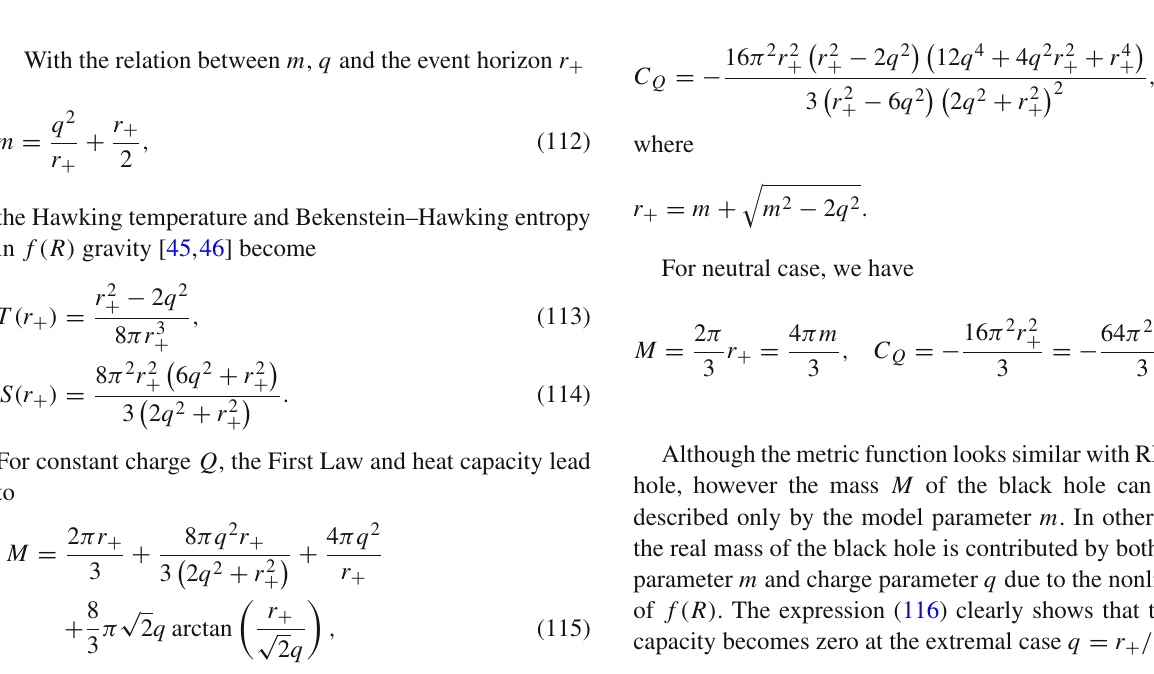
Fig. 4 The black curves represent RN black hole in Einstein gravity while the cyan curves represent our black hole in f ( R ) gravity in ( 3 + 1 ) - dimensions. In addition, the full lines, the dashed lines and the dotdashed lines correspond to q = 0 , 1 , 2